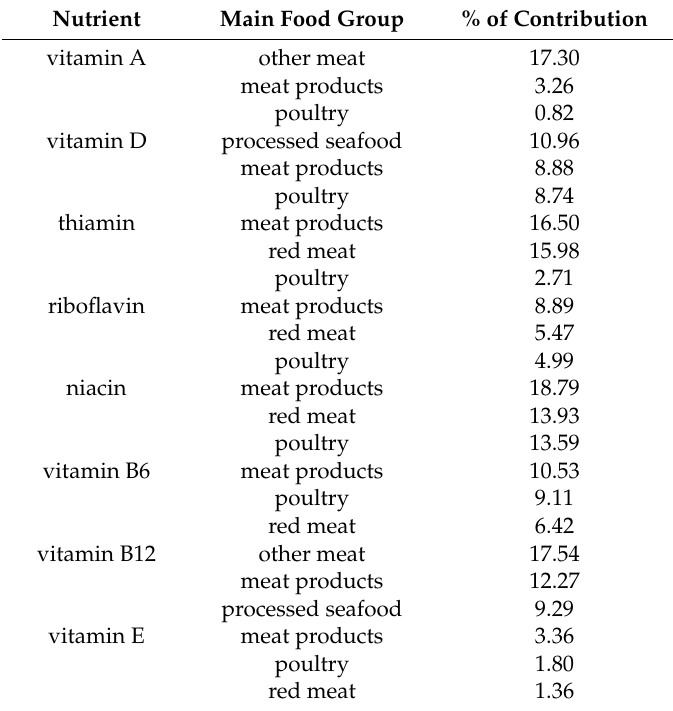
Table 8. Main food groups as sources of vitamins contribution from meat, meat products and seafood in the average Polish